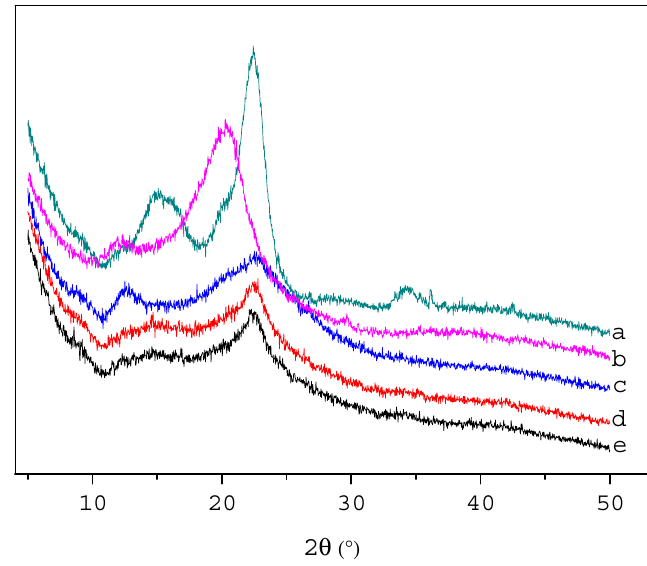
Figure 2. X-ray diffraction patterns of ( a ) CNC; ( b ) CS; c , CNC/CS3; ( d ) CNC/CS2; and ( e ) CNC/CS1.